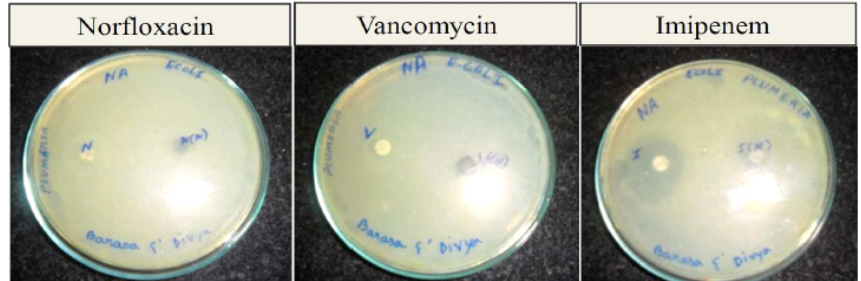
Fig. 3a. Antimicrobial activity of the gold nanoparticles synthesized from Frangipani against E.coli.